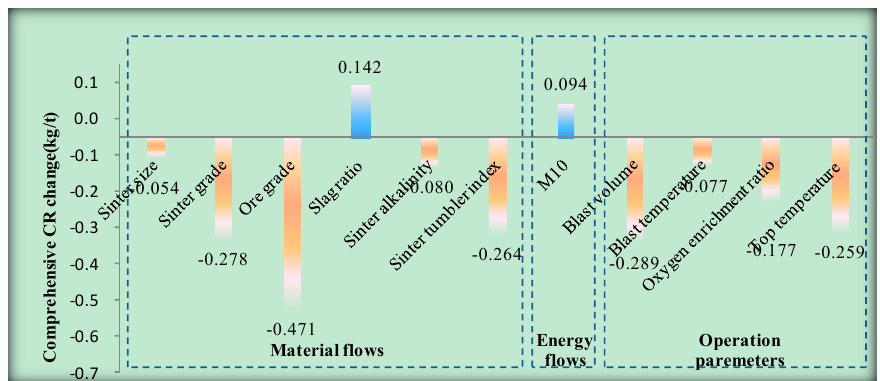
Figure 9. The comprehensive influence intensity of significant factors on CR.